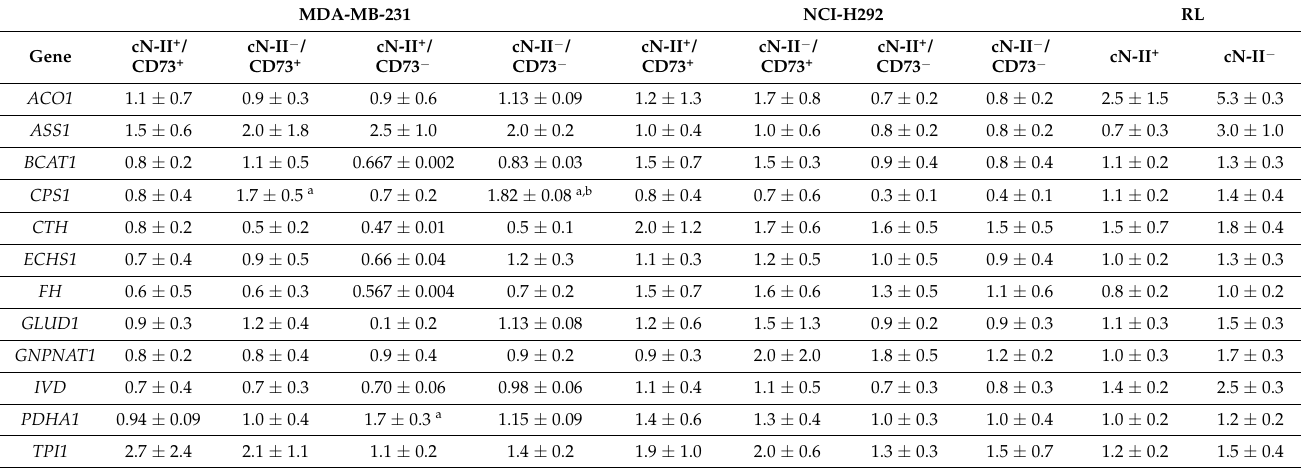
Table 4. Quantitative RT-PCR on identified genes in unexposed cells of the metabolic study. Values are means of four different samples ± standard deviation. a : p < 0.05 for comparison to cN-II + /CD73 + cells as determined by